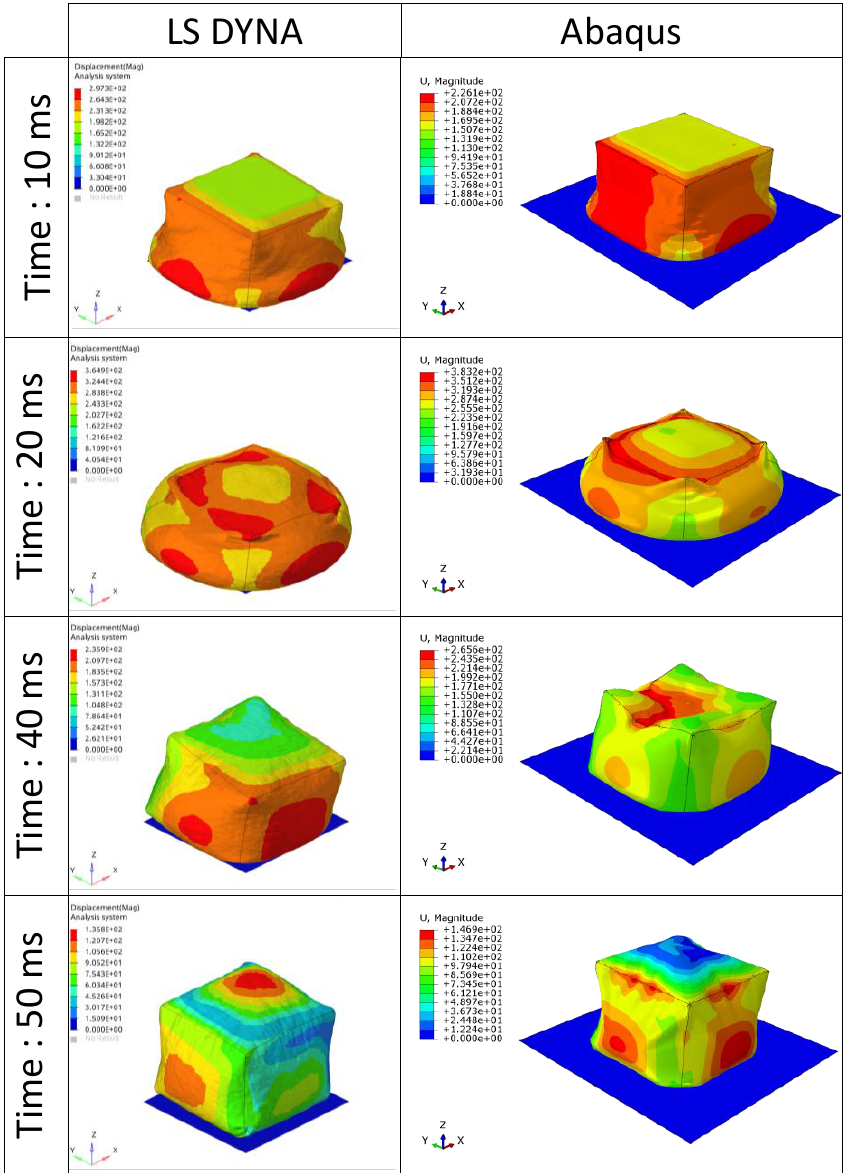
Figure 6. Global displacement contour plot. Left: Ls-Dyna model; right: Abaqus model.